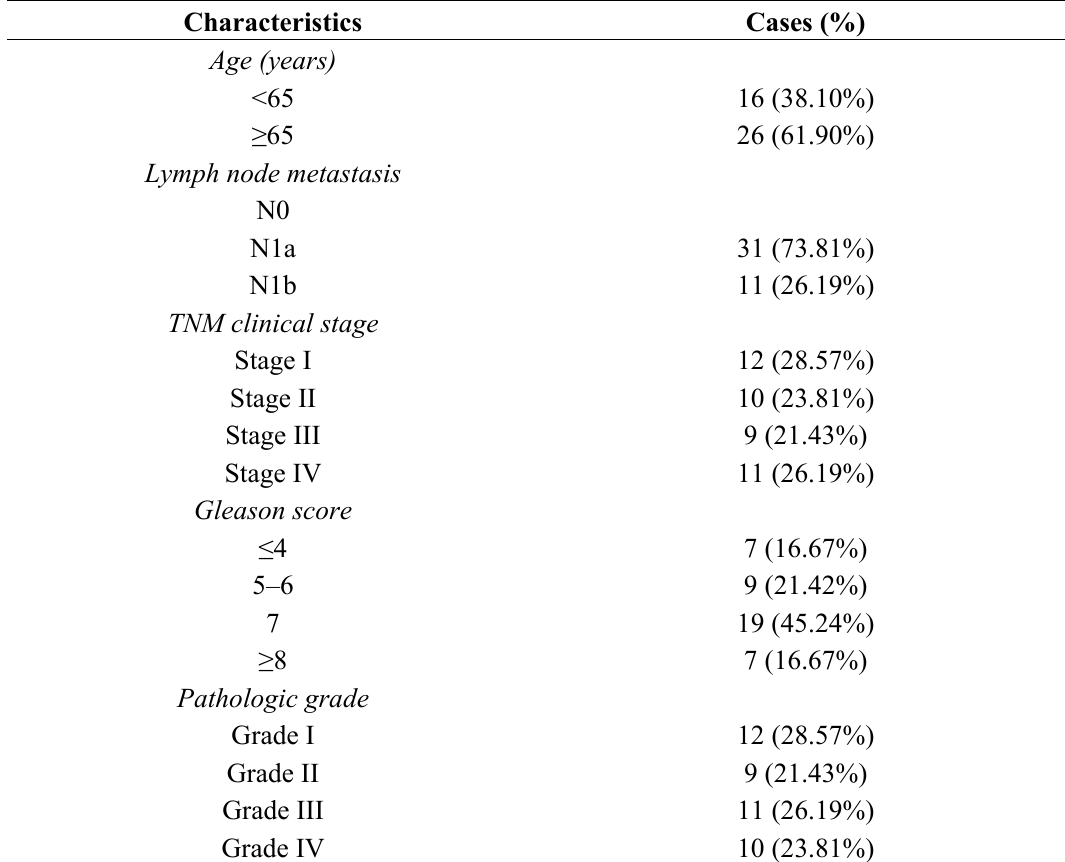
Table 1. Clinical characteristics of 42 PCa